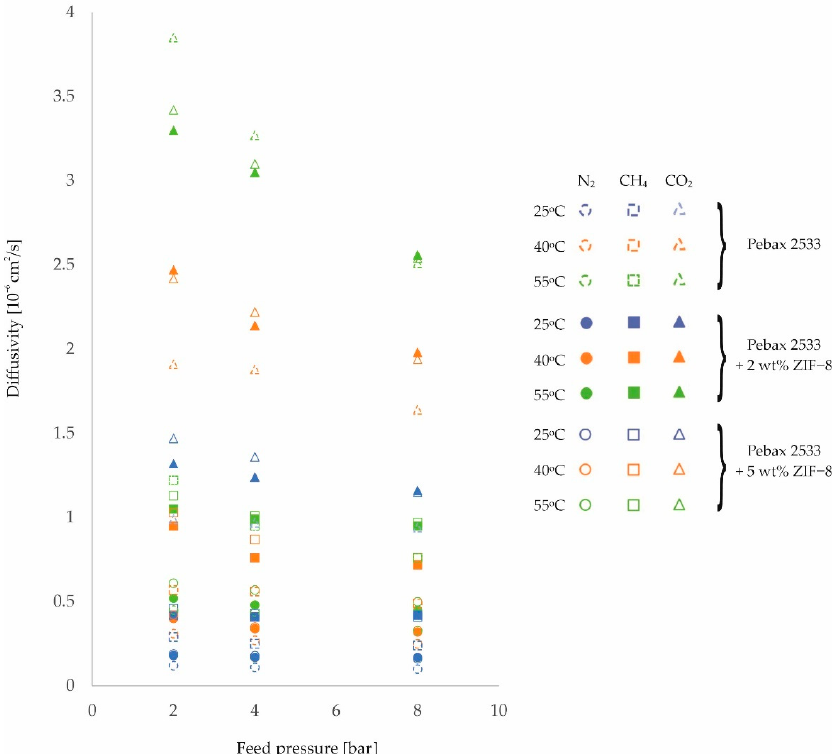
Figure 5. Change in diffusion coefficient values of homogeneous membrane and heterogeneous membranes containing ZIF − 8 for di ff erent feed pressure and temperature values.